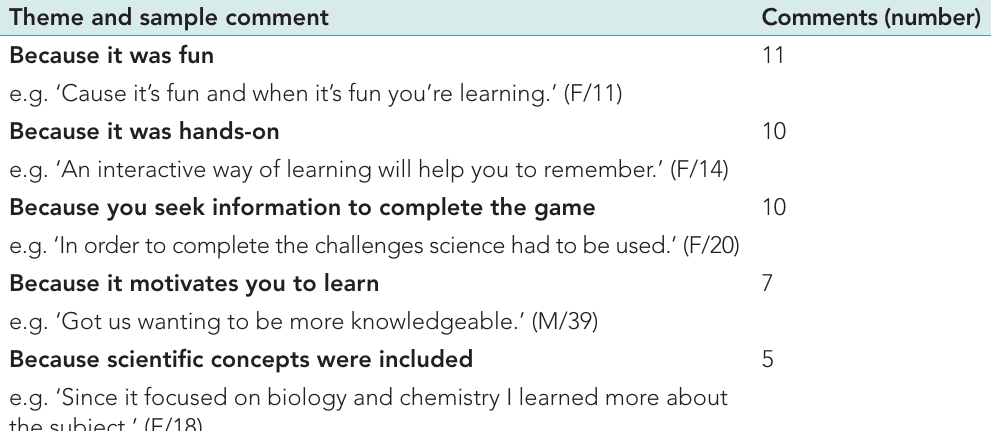
Table 3: explanations of responses to the question, ‘Is this a good way to learn science?’; gender and age of commenter is provided next to each sample comment (gender/age), n=48